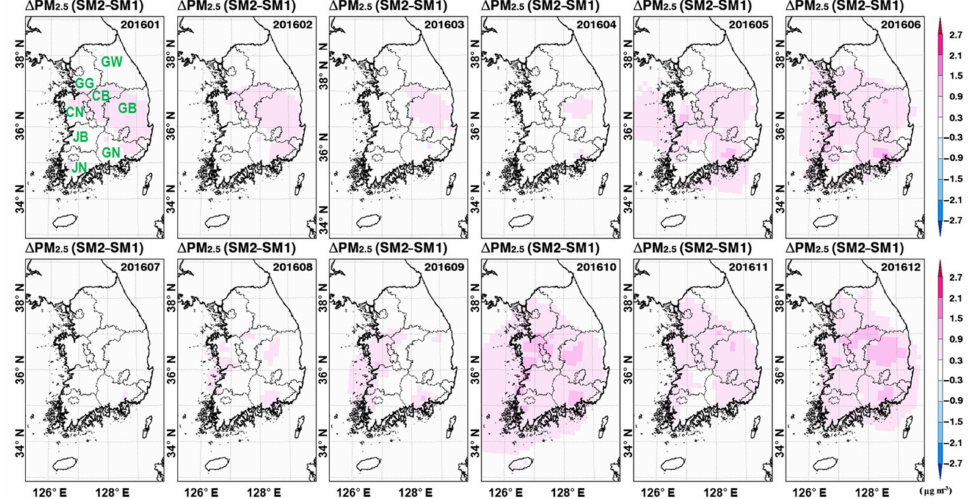
Figure 9. Spatial distributions of monthly absolute differences in PM 2.5 between SM1 and SM2 simulations (unit: µ g m − 3